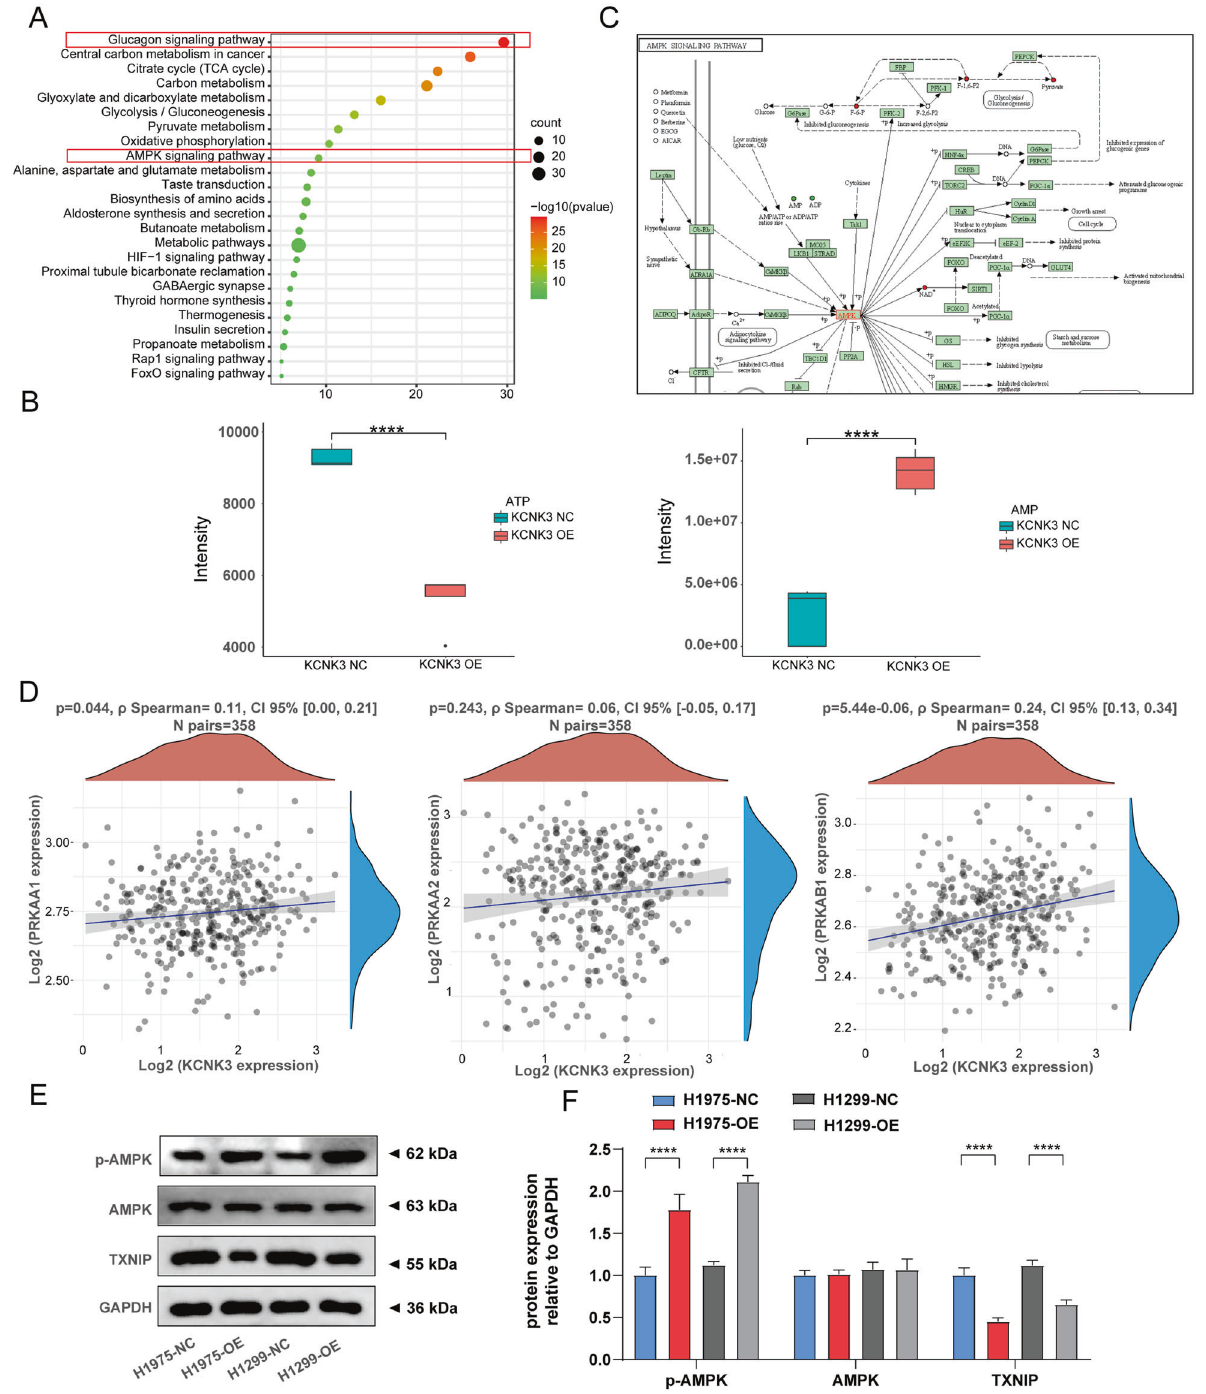
Fig. 5 KCNK3 activated the AMPK signaling pathway. A Differential metabolites were enriched in the glucagon signaling pathway and AMPK signaling pathway using KEGG databases. B Metabolic changes of ATP and AMP were detected by targeted metabolomics analysis. C Schematic diagram of the AMPK signaling pathway as presented in the KEGG database (http://www.genome.jp/kegg/). D Spearman ’ s correlation analysis of KCNK3 and AMPK subunits in LUAD patients from TCGA by using clinical bioinformatics database. E , F Relative p-AMPK, AMPK, TXNIP protein expression was measured by western blot after transfection with KCNK3 lentivirus in H1975 cells and H1299 cells, with results normalized relative to the expression of GAPDH. (Data are presented as the mean ± SD of three independent experiments. **** P <